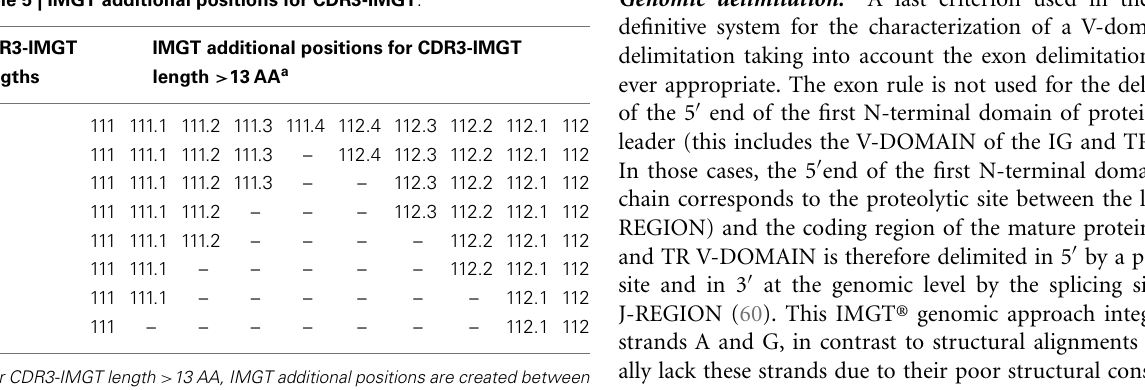
Table 5 | IMGT additional positions for CDR3-IMGT